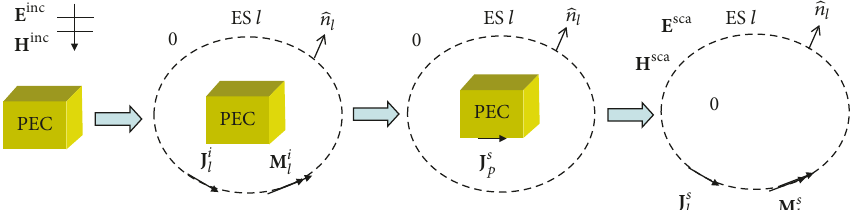
Figure 1: A PEC object characterized by equivalence surface with three